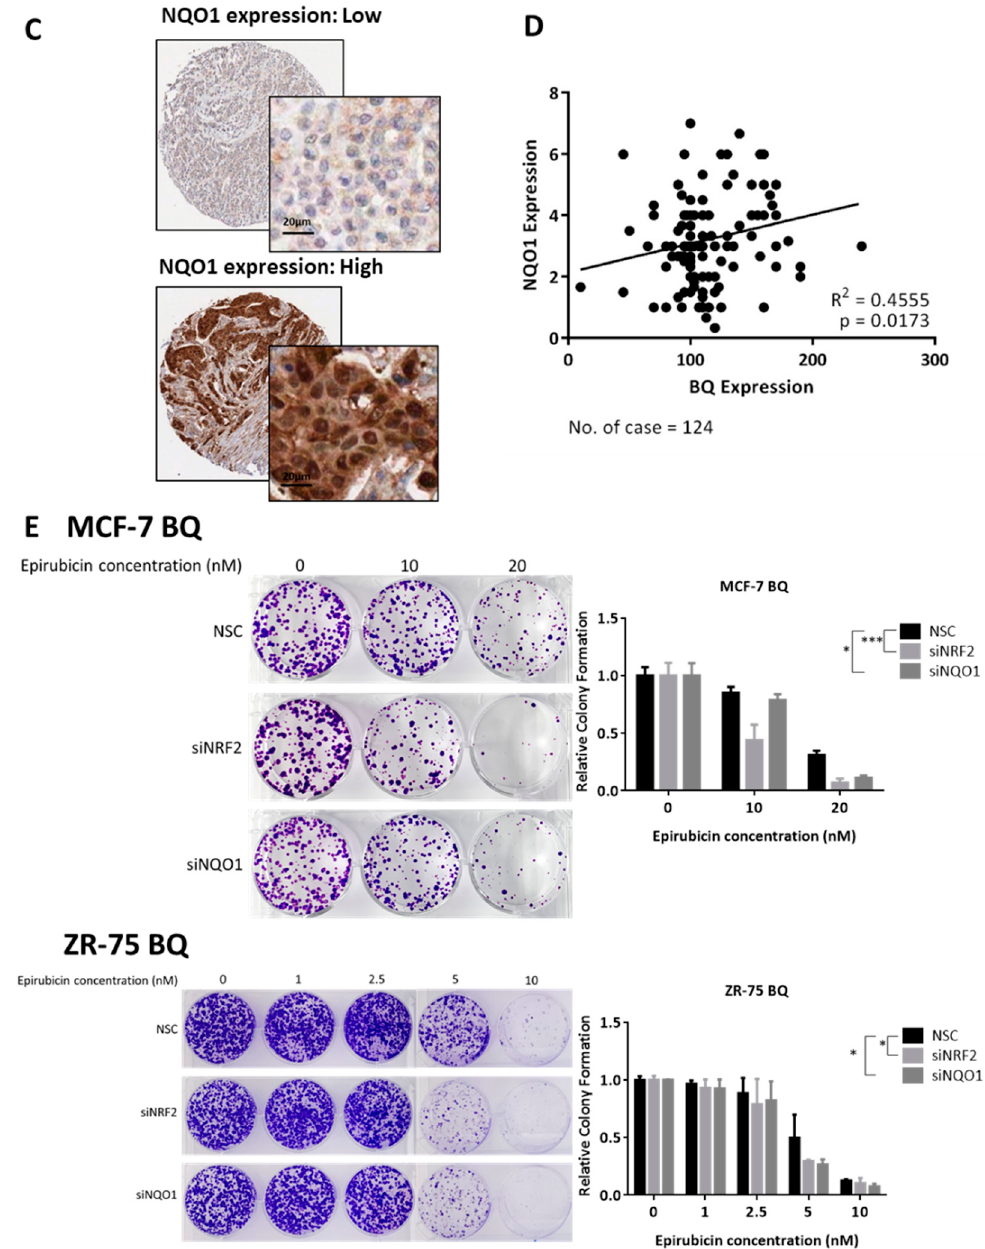
Figure 5. BQ overexpression leads to upregulation of antioxidant enzymes and modulates epirubicin resistance. ( A ) The effect of BQ overexpression on the expression of NQO1, HMOX1, GCLC,